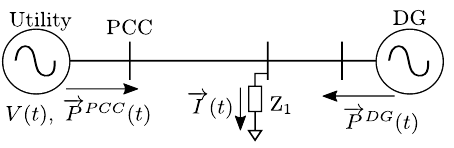
Figure 1. Equivalent